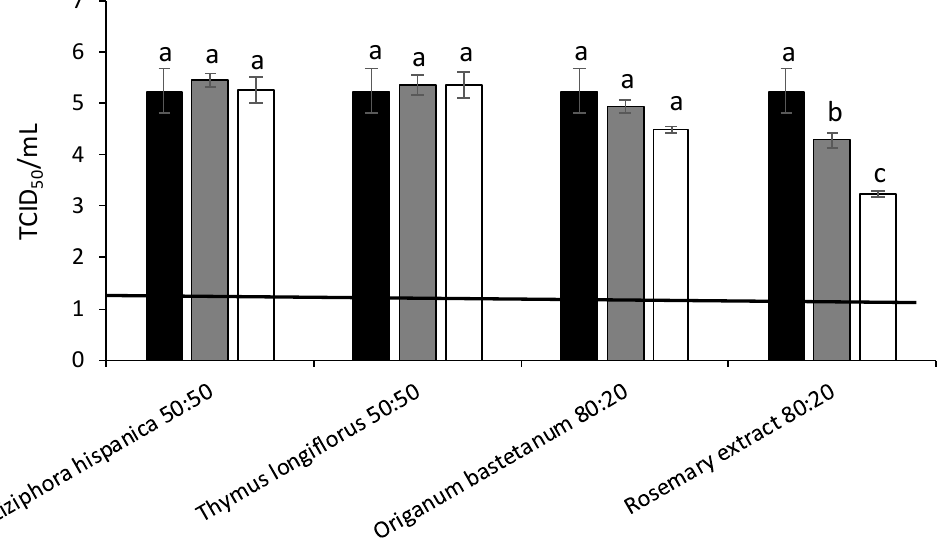
Figure 4. Reduction of hepatitis A virus (HAV) titers (log TCID50/mL) treated with different extracts after 37 ◦ C/ON incubations. Black bars: Control; Grey bars: 0.5 mg/mL; White bars: 5 mg/mL. Each bar represents the average of triplicates. Within each column, different letters denote significant differences between treatments. Horizontal line depicts the detection limit.